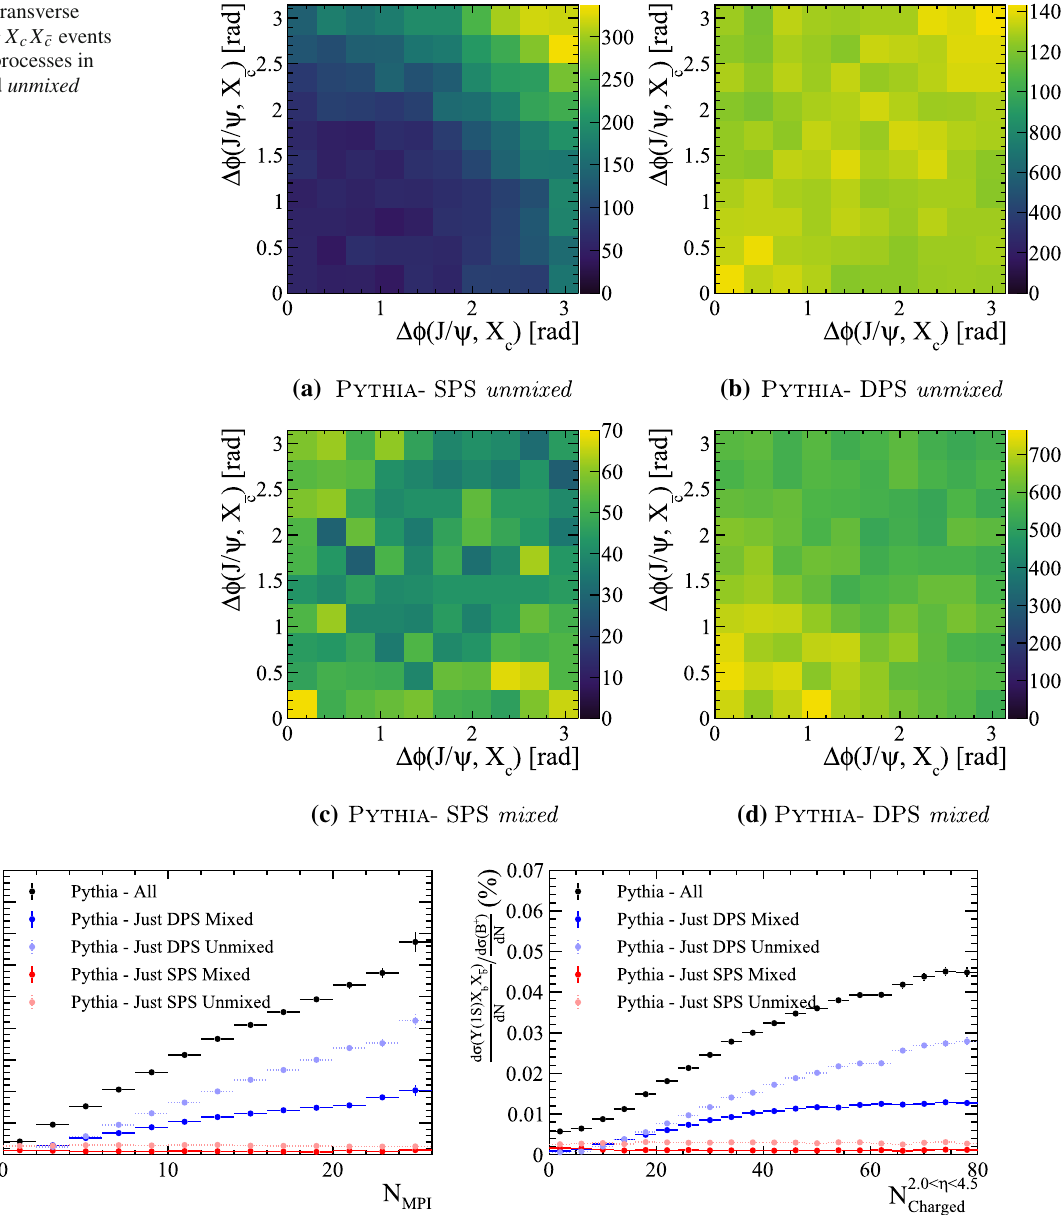
ent combinations of three SU(3) triplets (or antitriplets) into colour-singlet states, connected via Y-shaped “string junc- tions” [31]. In the limit of a small invariant mass between two heavy quarks, the junction topology (when allowed